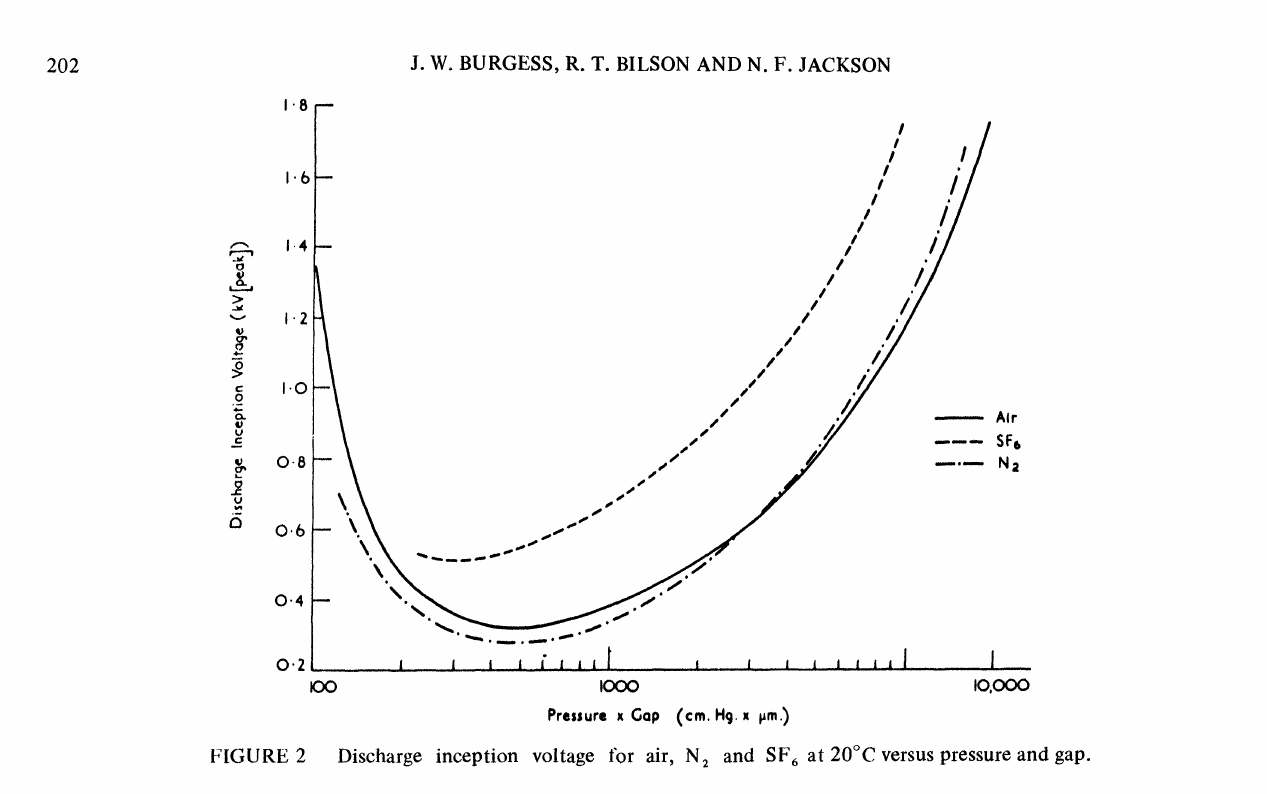
FIGURE 2 Discharge inception voltage for air, N and SF at 20C versus pressure and